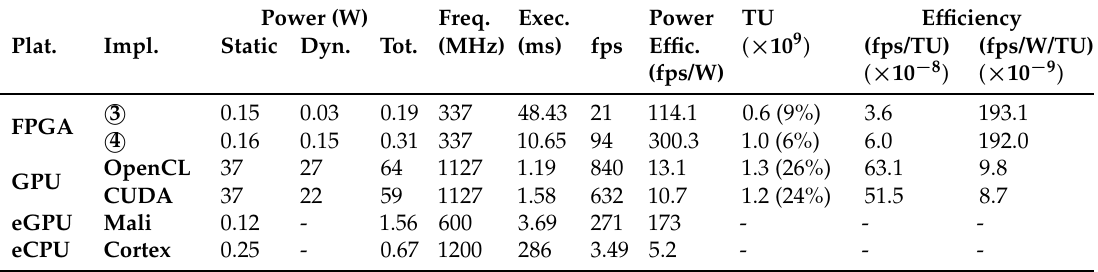
Table 10. Power, resource and combined efficiency comparisons for k -means clustering for Xilinx